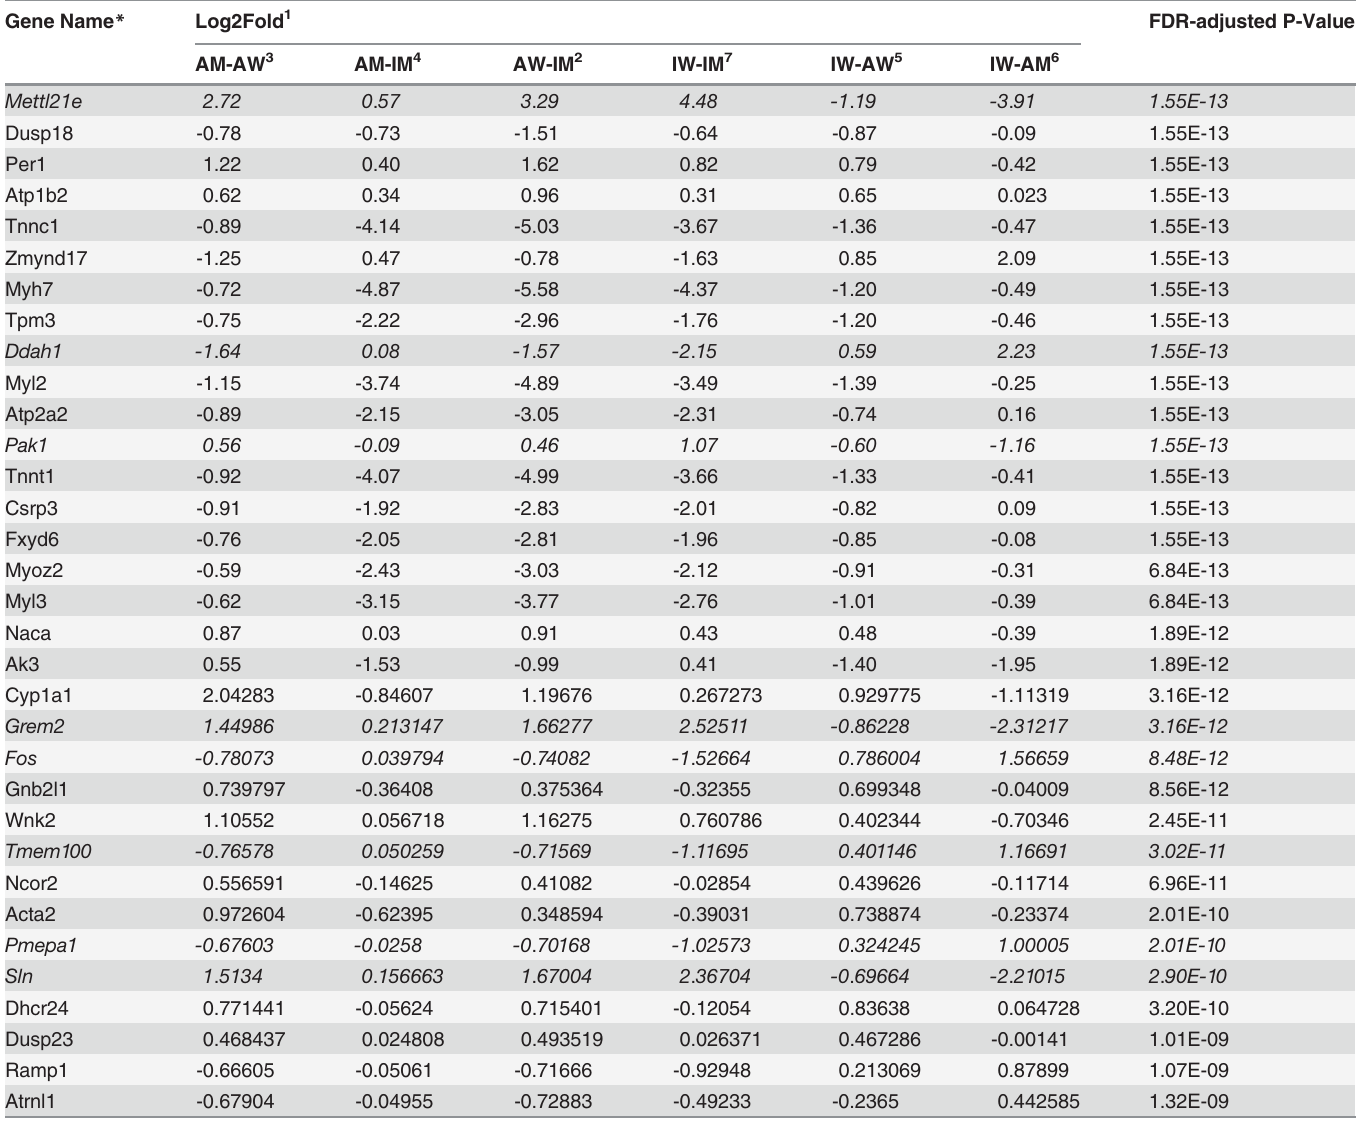
Table 1. Differentially expressed genes (FDR-adjusted P-value < 2XE-9) across activity-genotype